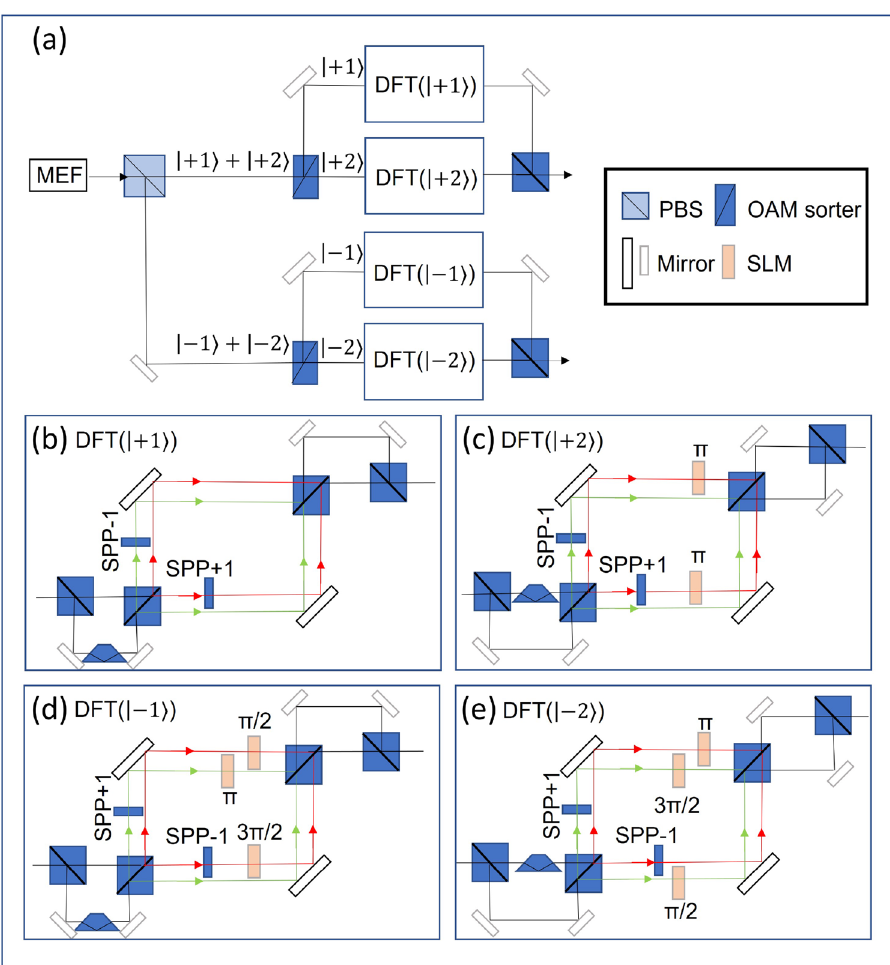
Figure 4. Optical path diagram of DFT in Shor’s algorithm. The work register is measured to different polarization directions by a PBS. Each beam is sorted by an OAM sorter into two beams with different OAM and then emulates the DFT individually. Finally combining the beams and getting the output related to the order. SLM is phase-only spatial light